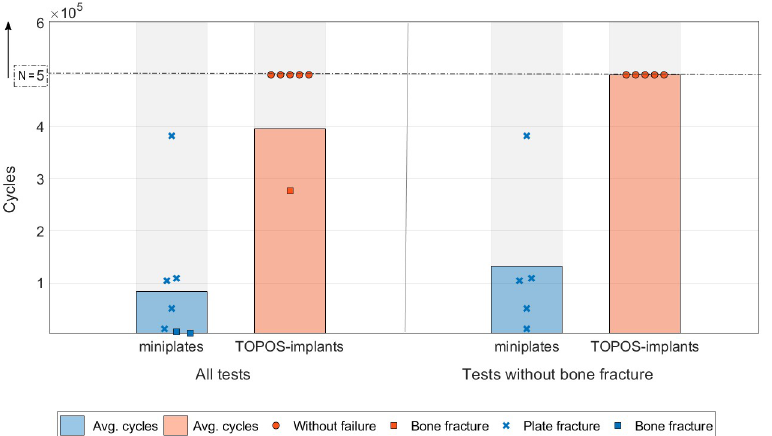
Fig 6. Results of the dynamic tests. Graphical visualization of the biomechanical comparison of miniplates with patient specific, topology optimized (TOPOS-)implants. The bars show the average of the passed cycles per group with 500 000 cycles at maximum. For comparing of fatigue properties of the implant types only test runs without bone fracture are used (statistics: significant ( � ) p < 0.05, highly significant ( �� ) p < 0.01).